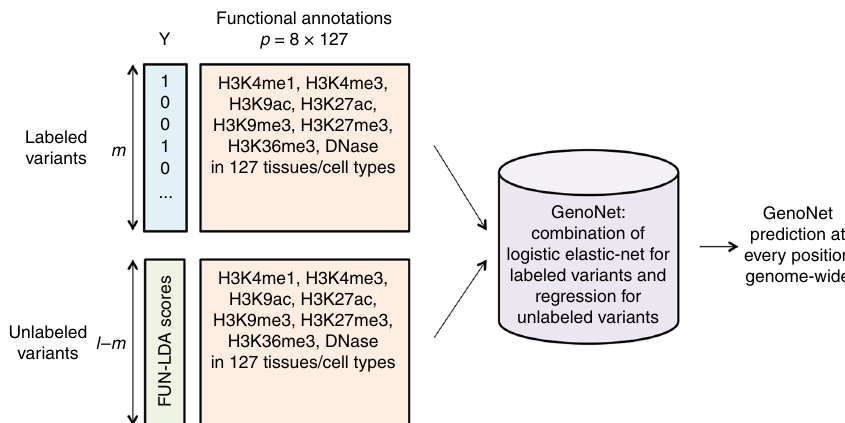
Fig. 1 GenoNet work fl ow. GenoNet integrates experimentally validated variants ( m (cid:1) 0 labeled variants), millions of unlabeled variants genome-wide ( l – m unlabeled variants), and more than a thousand cell type/tissue-speci fi c functional annotations ( p ) on each variant to predict the functional consequences of genetic variants at positions